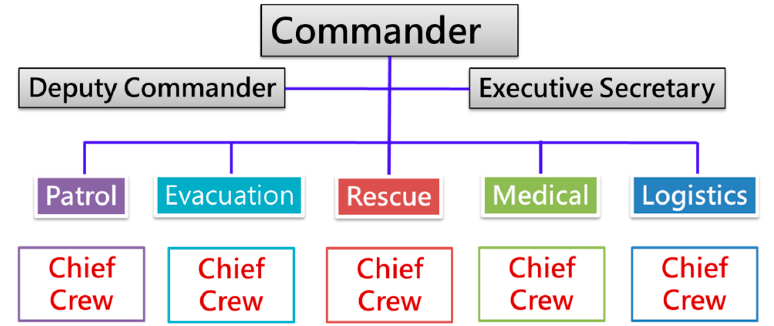
Figure 3. Typical Resilient Community Response Team in New Taipei City (NTPC).